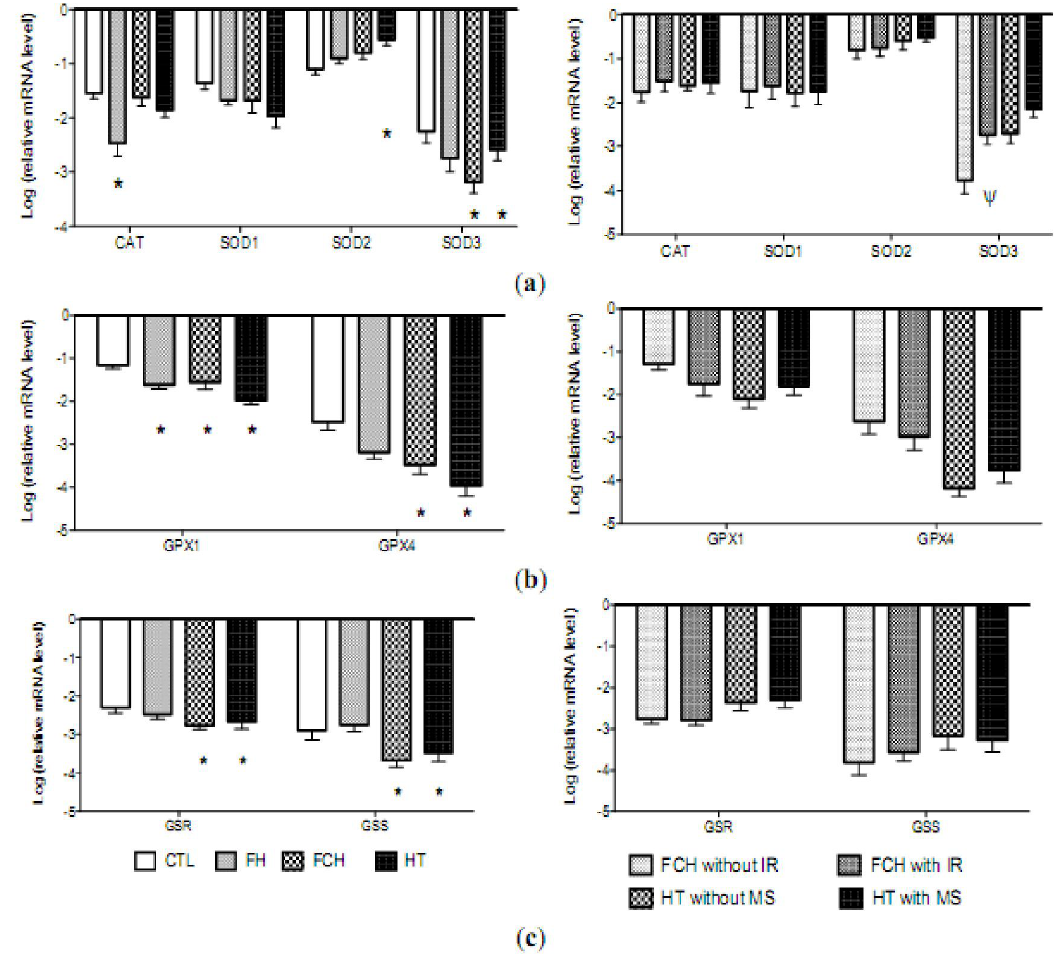
Figure 2. Log ratio relative mRNA values for ( a ) catalase (CAT), intracellular